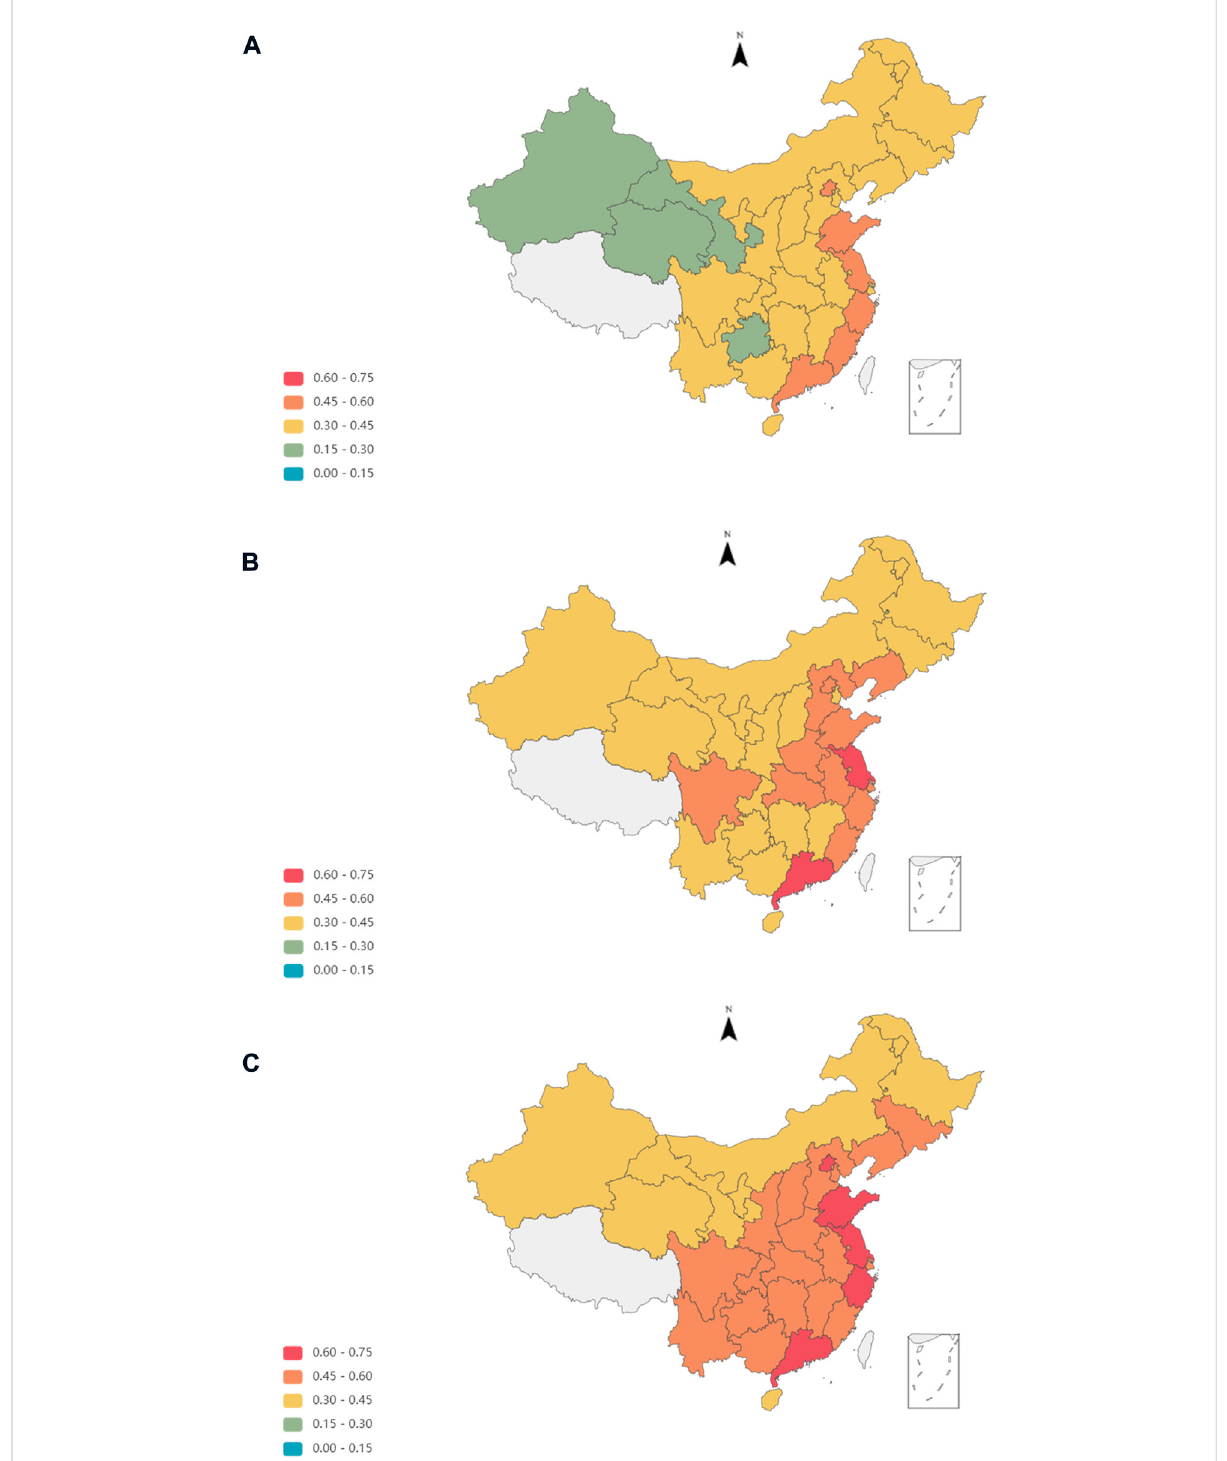
FIGURE 2 The heat map of CCD scores by province. (A – C) indicate the heat map of 2011, 2015, and 2019,